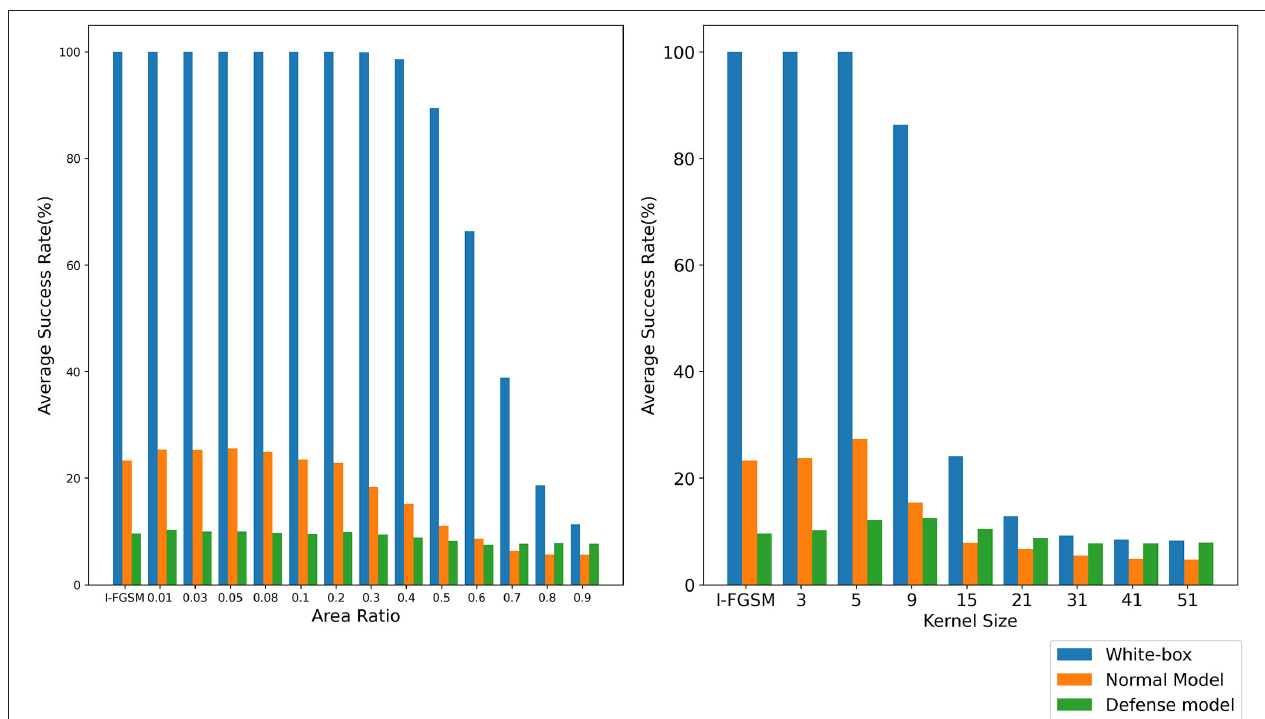
FIGURE 2 | The attack success rate (%) on seven models, the adversarial examples are crafted by REI-FGSM on Inc-v3 model with different area ratios. The attack success rate (%) on seven models, the adversarial examples are crafted by random erasing and Gaussian blur on Inc-v3 model with different area ratios and kernel size in the original